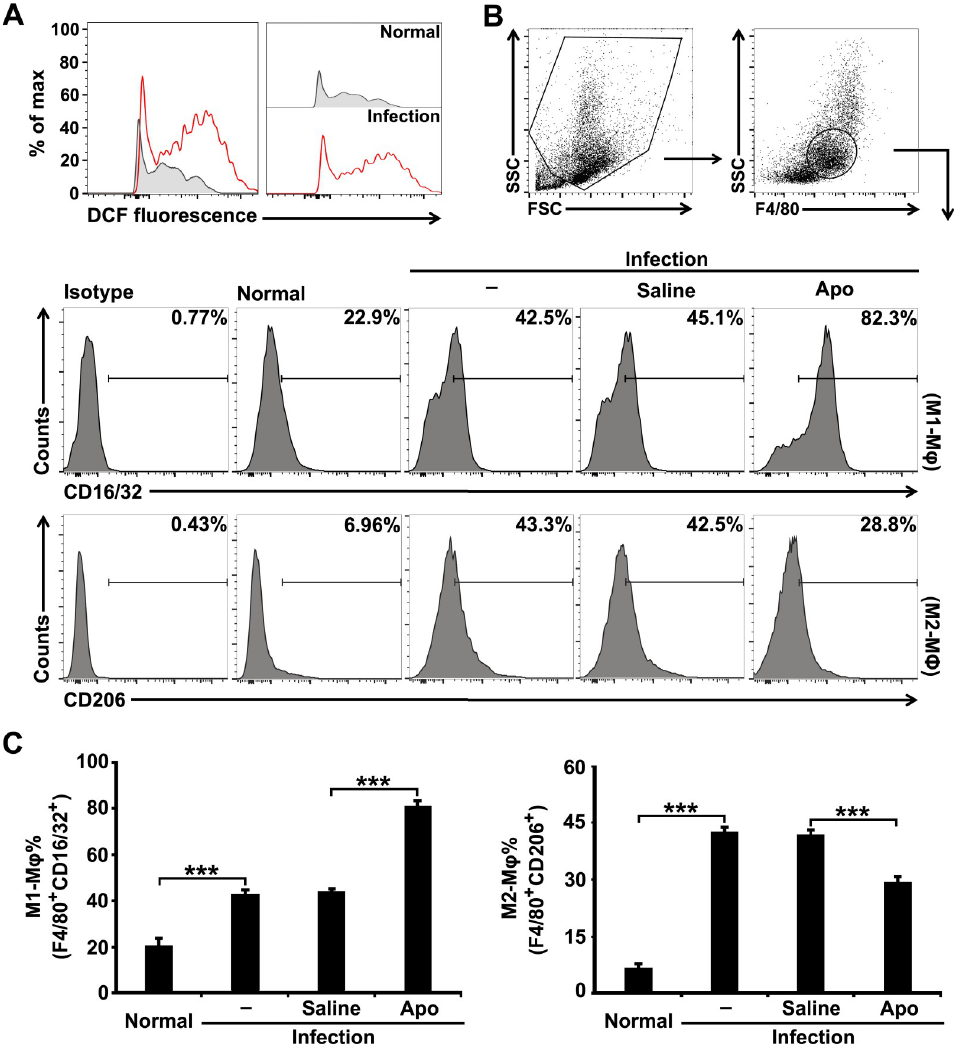
Fig 3. Blocking ROS production inhibits M2 but promotes M1 macrophage differentiation in S . japonicum - infected mice. (A) ROS production in macrophages from normal or infected mice was detected by FCM using the ROS- sensitive probe DCFH-DA. Normal, uninfected mice. (B and C) S . japonicum -infected mice were treated with saline or Apo. Expression of CD16/32 (M1) and CD206 (M2) on F4/80 + macrophages were detected by FCM analysis. Representative histograms gated on F4/80 + macrophages were shown (B). The bar graphs show the average percentages of F4/80 + CD16/32 + M1 or F4/80 + CD206 + M2 macrophages (C). Data are expressed as the means ± SD of four mice per group and representative of three independent experiments. ��� P <